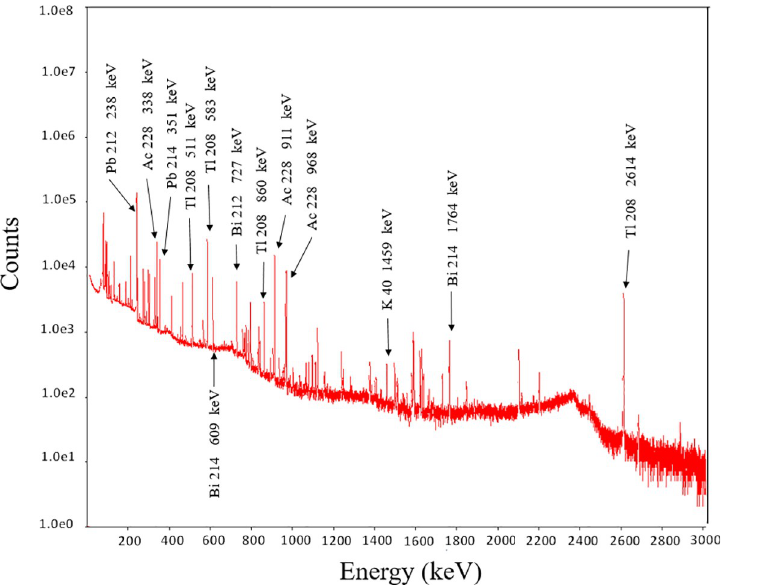
Fig 5. Example spectra obtained from an MP15 metallic scalar pendant